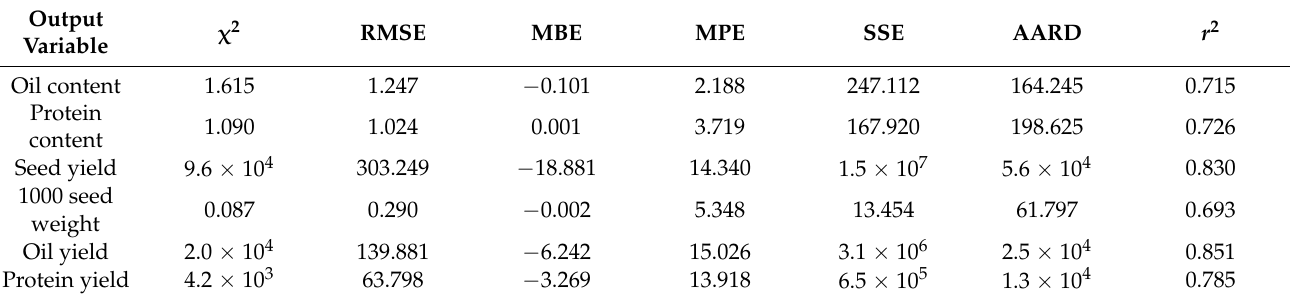
Table 5. The goodness of fit tests for the developed RFR model. Output Variable χ 2 RMSE